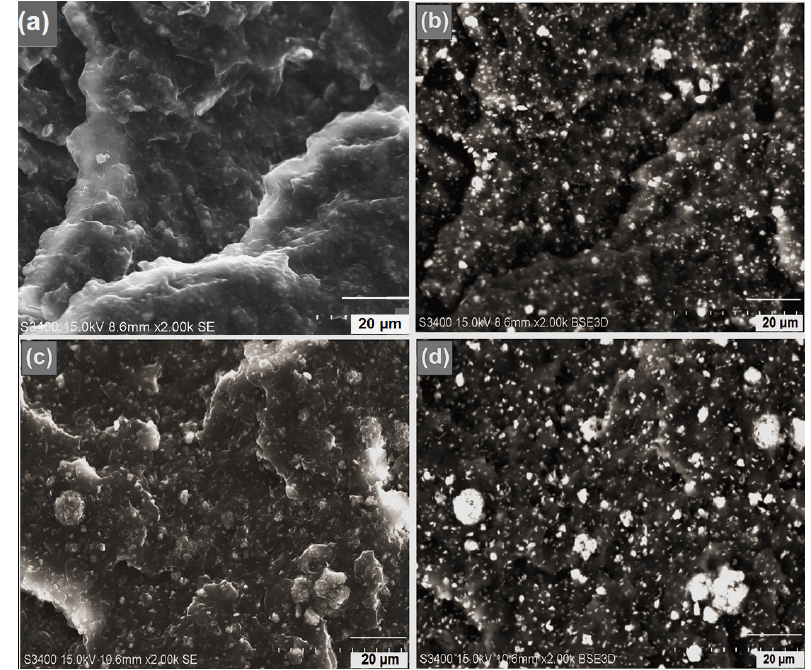
and (c, d) (BSE) unmodified PP/PP-g-MAH/30%Mg(OH) 2